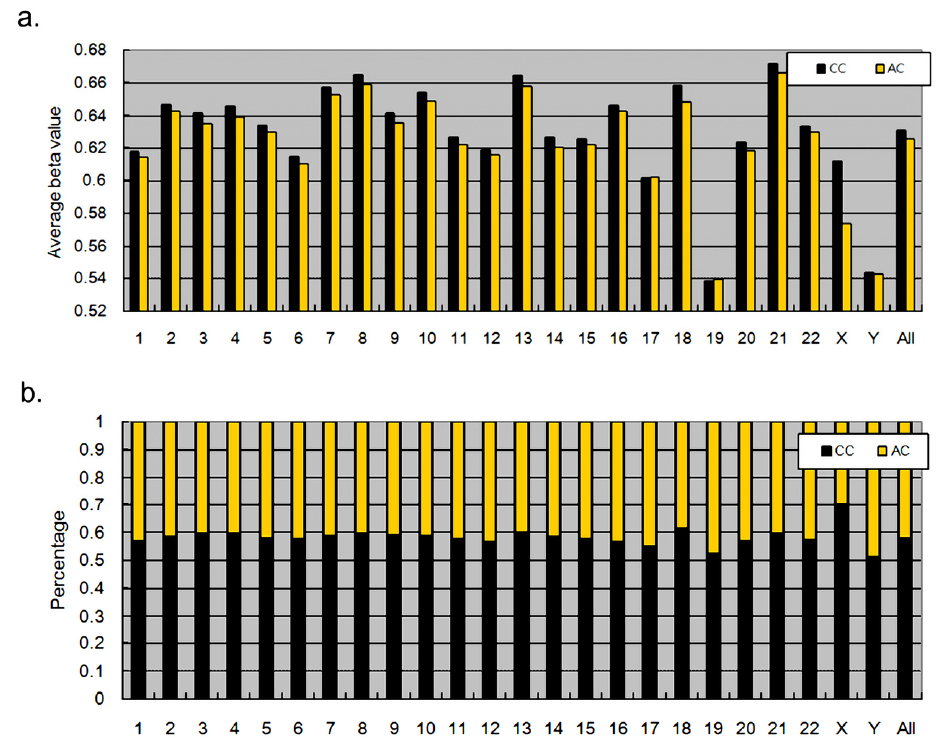
Figure 2. Comparisons of neonatal and adult CpG methylation in chromosomes. ( a ) The comparison was conducted based on the average β -values of CpG dinucleotides in each chromosome. ( b ) The comparison was conducted based on the percentage of cases in which β cc was larger than β ac. In the ‘All’ set, this β cc > β ac tendency was significant (Fisher’s t -test, p < 0.001). 3.3. Genes with Significantly Different CpG Dinucleotides between CC and AC Samples Were Mainly Involved in Cell Adhesion and Metabolism Apart from general differences in DNA methylation, we also identified genes with sig- nificant differences in CpG dinucleotides between sets CC and AC. As shown in a principal component analysis plot (Figure 3a) based on DNA methylation profiles, the CC samples were clearly separated from the AC samples, suggesting high discrimination between CC and AC samples. Specifying false discovery rate (FDR) < 0.05 and β -variation > 0.1, 33, 150 CpG dinucleotides showed significant variation with 14,699 CpG dinucleotides hyperme- thylated and 18,451 CpG dinucleotides hypomethylated in AC samples (Figure 3b). To identify the genes regulated by these significant CpG dinucleotides, CpG dinu- cleotides were mapped back to the genome, and we examined whether they were located at the putative promoter regions ( − 5000 upstream to +3000 downstream of transcription start site) of genes as suggested in a previous study [32]. As a result, 11,660 CpG dinu- cleotides were found to be located at the respective promoter regions of 7730 genes. We further conducted a pathway enrichment analysis on these genes using Partek. As shown in Supplementary Table S2, 24 significant pathways were identified, and most of them were associated with synthesis of cell adhesion molecules and metabolic functions. The summary of significantly altered CpG dinucleotides, genes and enriched pathways was also available in Table